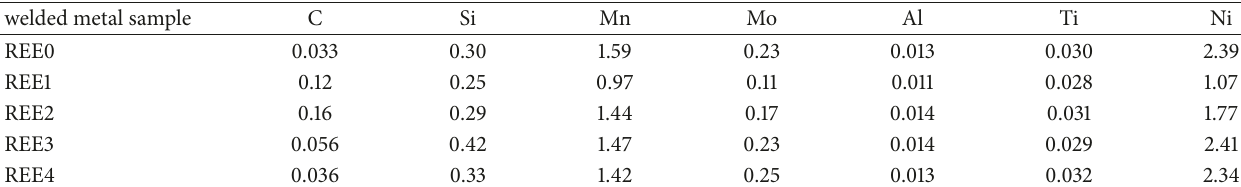
Table 6: Chemical composition of the welded metals (wt. %).